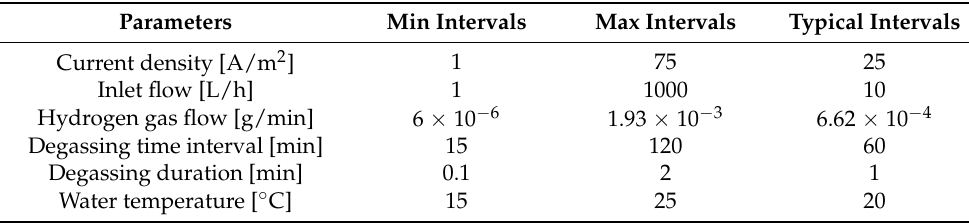
Table 1. Operational conditions of the EC device for different experiments.